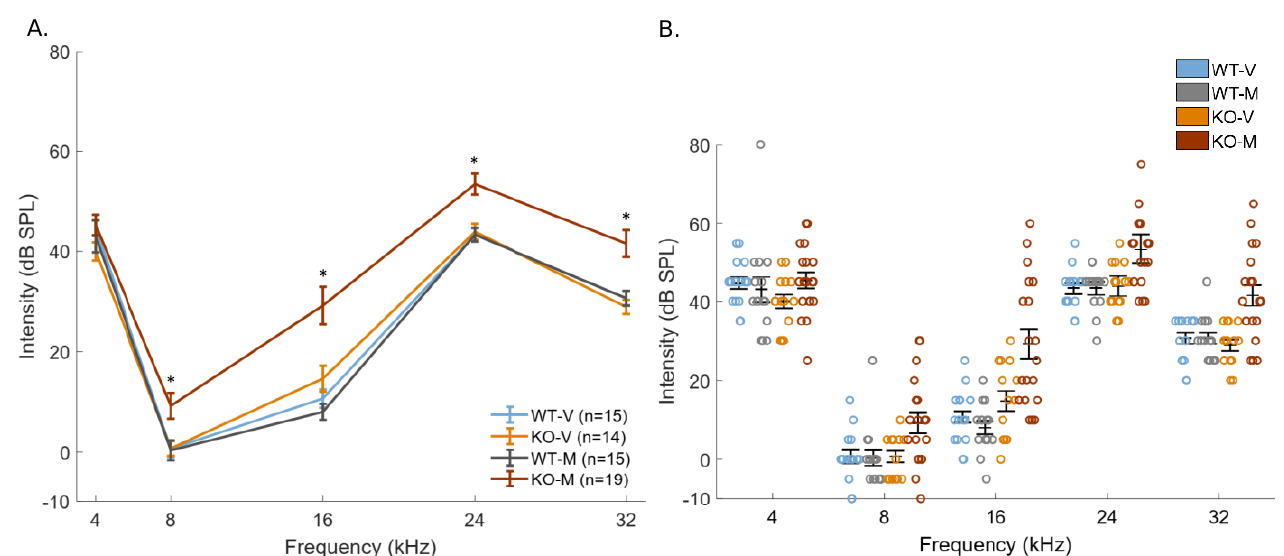
Figure 2. The mean ABR thresholds for the four groups. ( A ) Pure tones (at 4, 8, 16, 24, and 32 kHz) were presented at different intensities (between 70 and − 10 dB SPL) and the auditory brainstem response (ABR) thresholds were determined for each frequency (wave III threshold measurement). Each point represents the average threshold ( ± s.e.m.) of each group at different frequencies. The ABR thresholds measured in WT virgins (blue), TPC KO virgins (orange), and WT mothers (gray) mice, were not different between groups. Only the thresholds of the TPC KO mother mice (brown) were significantly higher at 8, 16, 24, and 32 kHz than the other groups. ( B ) The individual ABR thresholds at 4, 8, 16, 24, and 32 kHz in each group are represented by circles. The average threshold and standard error are represented by horizontal markers. The * indicate significant difference ( p < 0.05) between TPC KO mothers and WT mothers.